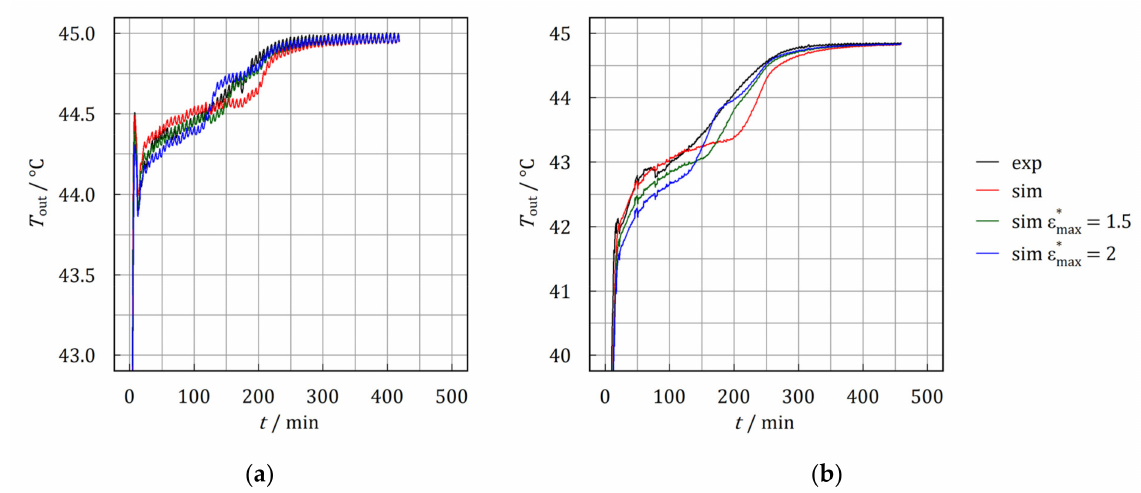
Figure 15. Outlet temperature of the storage of experiment (exp) and simulation (sim) without and with additional enhancement of the thermal conductivity for a mass flow rate of 180.4 kg/h ( a ) and 43.0 kg/h ( b